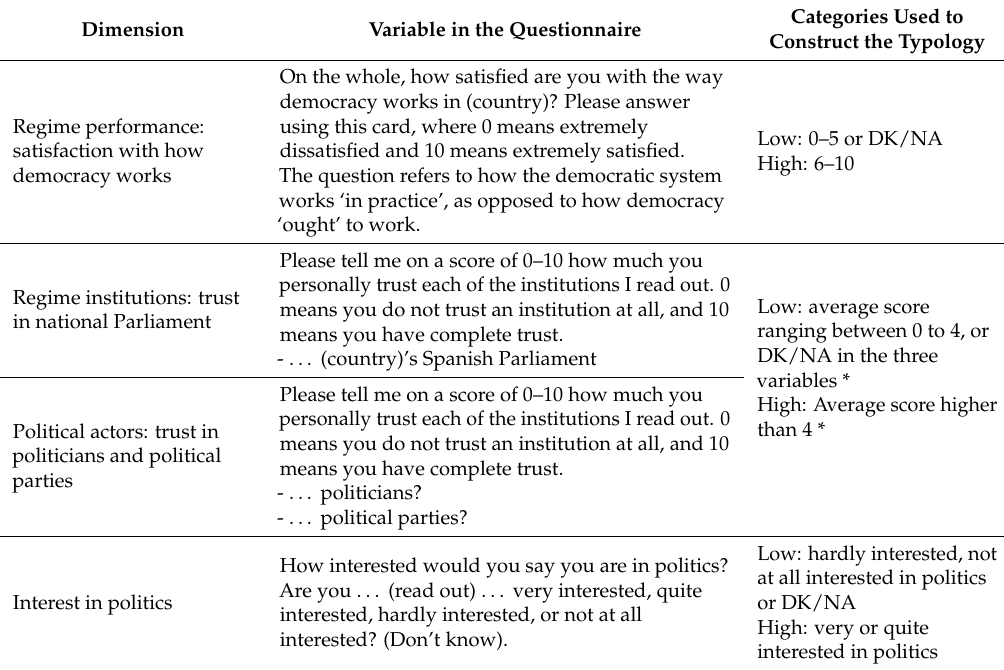
Table A1. Operationalization of the dimensions included in our typology of attitudes towards politics.